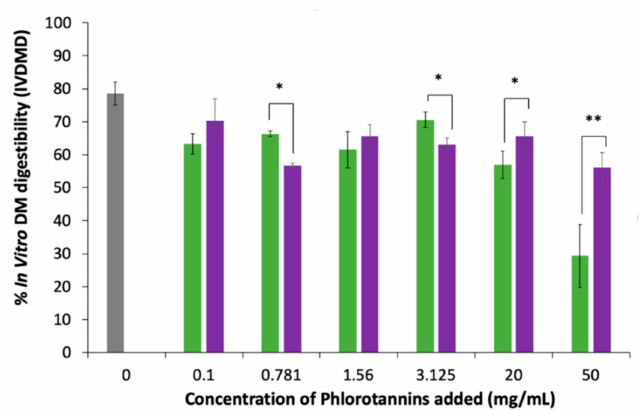
Figure 5. In vitro DM digestibility (IVDMD) of a commercial pig feed when di ff erent concentrations of phlorotannins isolated from A. nodosum (purple) and F. serratus (green) in May were added. Control (commercial pig feed, grey) (* = p < 0.05; ** = p <